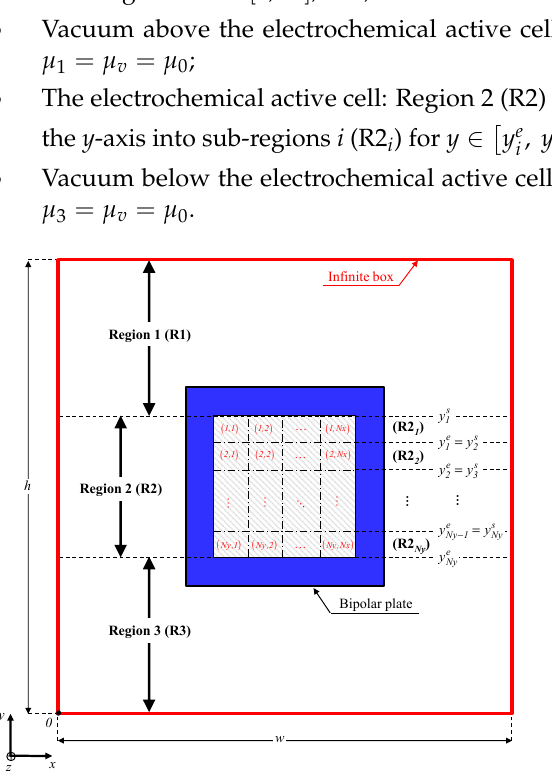
Figure 3. Definition of regions in the bipolar plate for the diagnosis of a PEMFC stack.